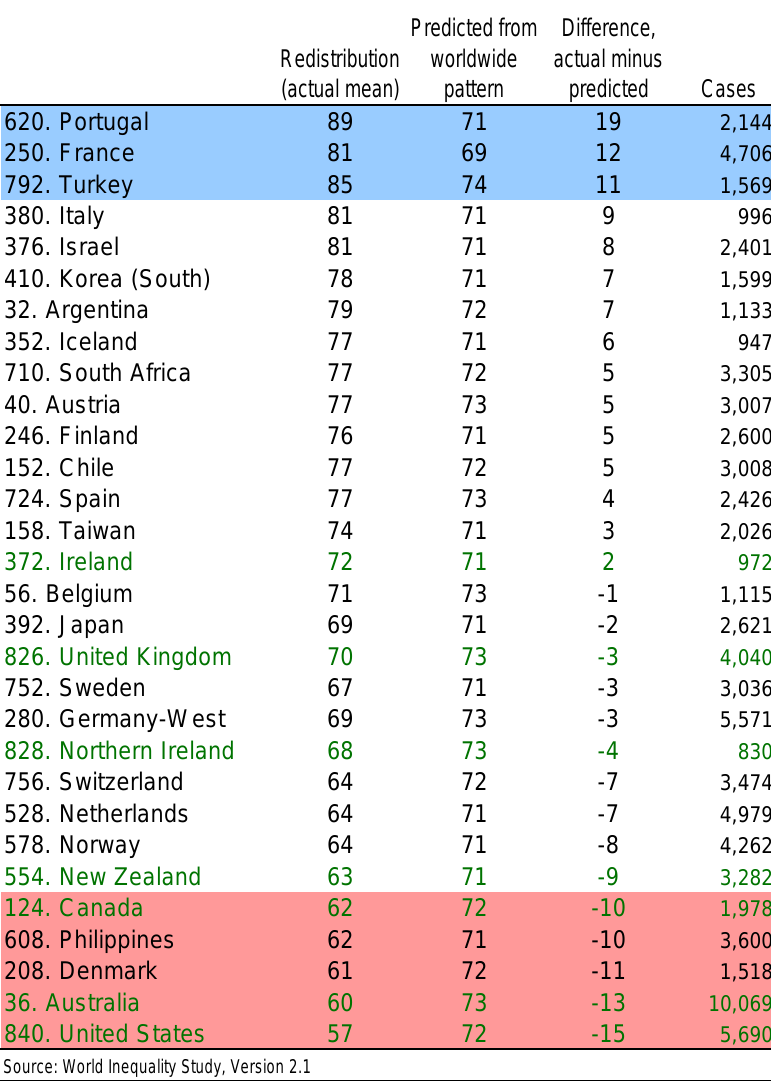
Figure 15. Differences between individual countries in attitudes toward income redistribution: Divergence from the worldwide pattern. Most supportive countries highlighted in blue, least supportive in red. English speaking countries (green type) average about 10 points less supportive of redistribution net of everything else (t = − 3.55, p < 0.001).